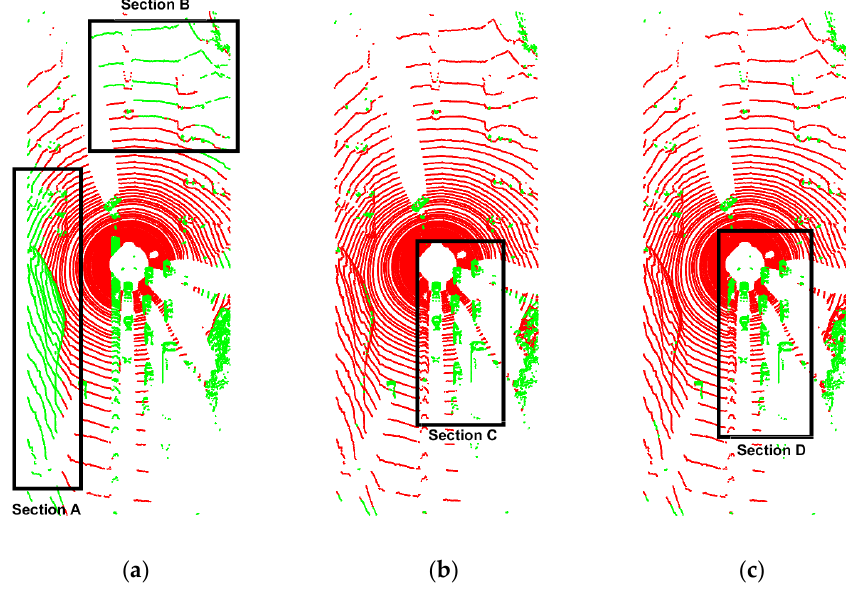
Figure 7. Comparison of segmentation result of three types of algorithms in dataset 2011_09_26_drive_0018. ( a ) RANSAC algorithm. ( b ) RGF algorithm. ( c ) Proposed algorithm.